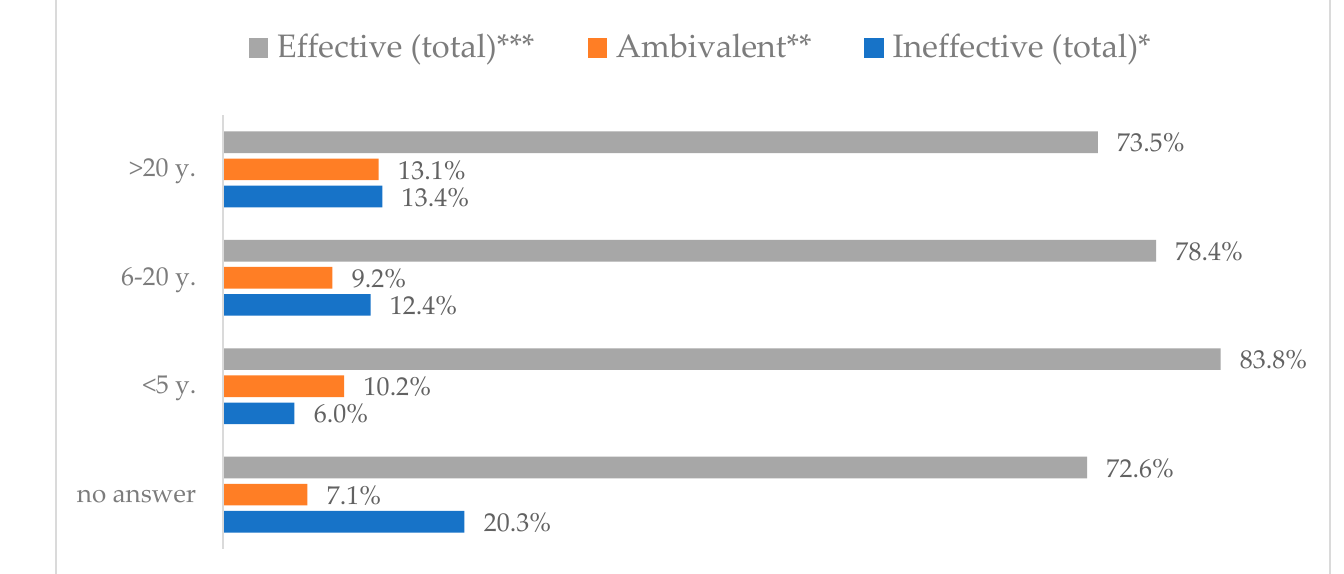
Table 7. Evaluation of eating garlic to prevent influenza virus infection by sociodemographic cate- gory ( N = 950). Variables Mean 95% CI SE MD OR